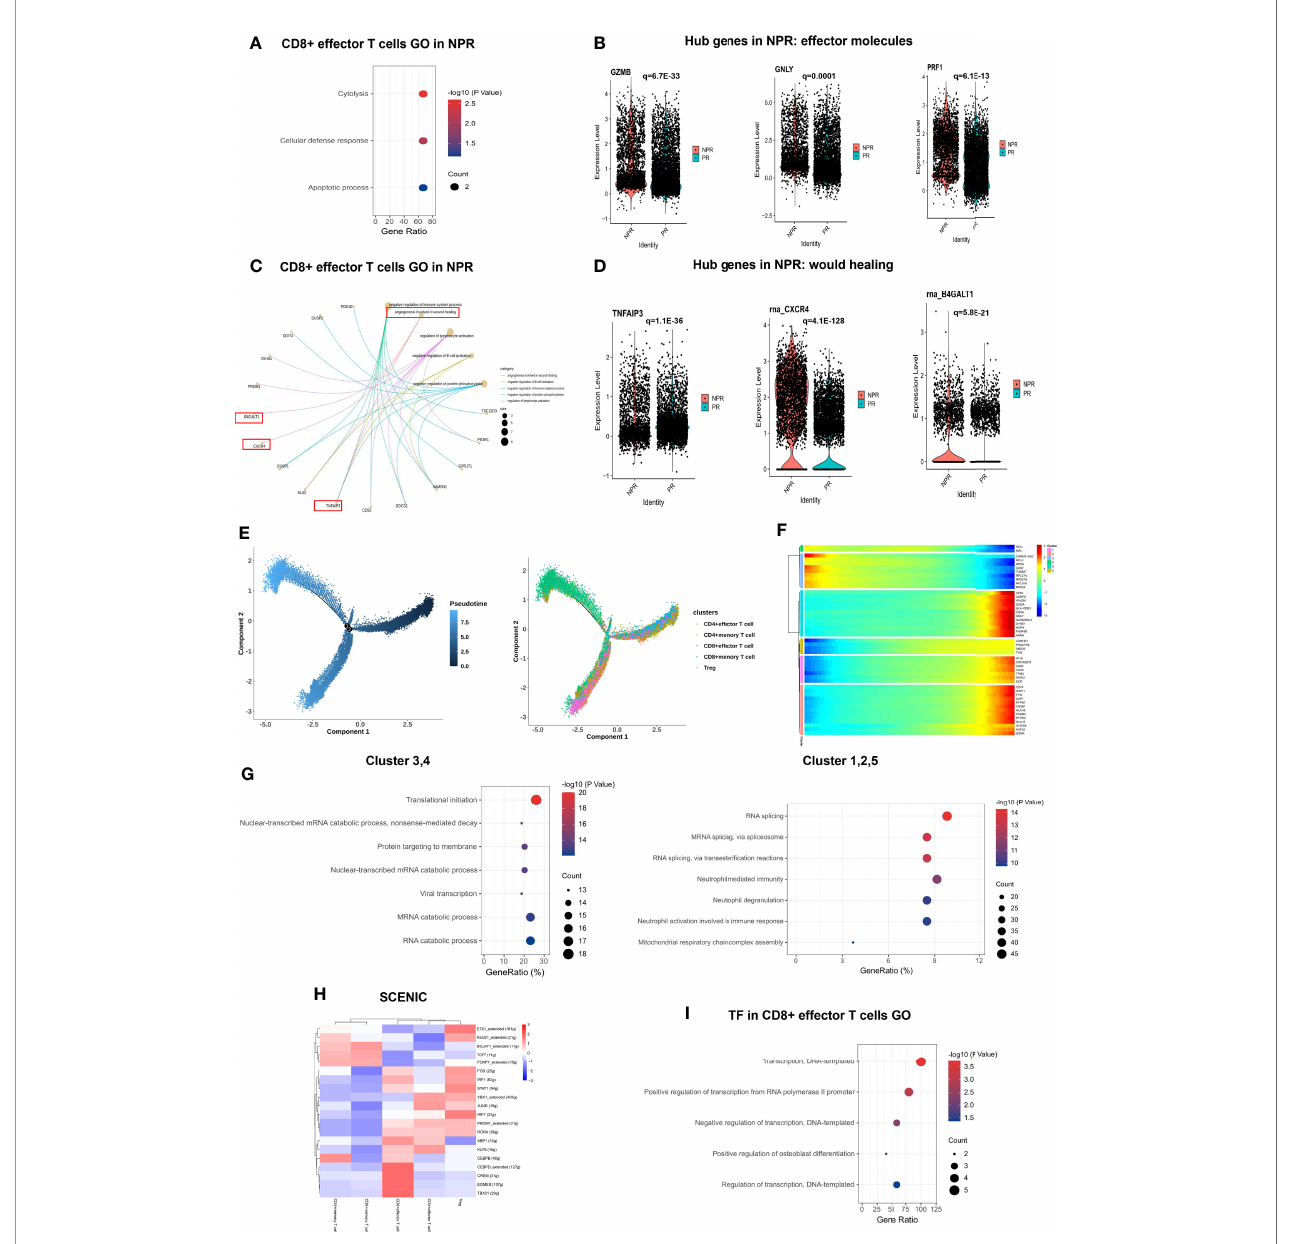
FIGURE 5 | Impact of plaque rupture and without rupture on gene regulation and development trajectory of circulating T cells. (A, B) Expression of effector molecules associated with apoptosis and desquamation of endothelial cells as GZMB, GNLY, and PRF1 in CD8 + effector T cells of patients with NPR. (C, D) Expression of angiogenesis and wound healing genes as TIFAIP3, CXCR4, and B4GALT1 in CD8 + effector T cells of patients with NPR. (E) The developmental trajectories of different T cell subtypes with pseudo-time analysis. (F) Heatmap of signi fi cantly upregulated genes in pseudo-time developmental trajectories. (G) GO analysis of upregulated genes in different clusters in a pseudo-time analysis. (H) Heatmap of upstream transcription factors in T cell subtypes. (I) GO analysis of transcription factors in CD8 + effector T